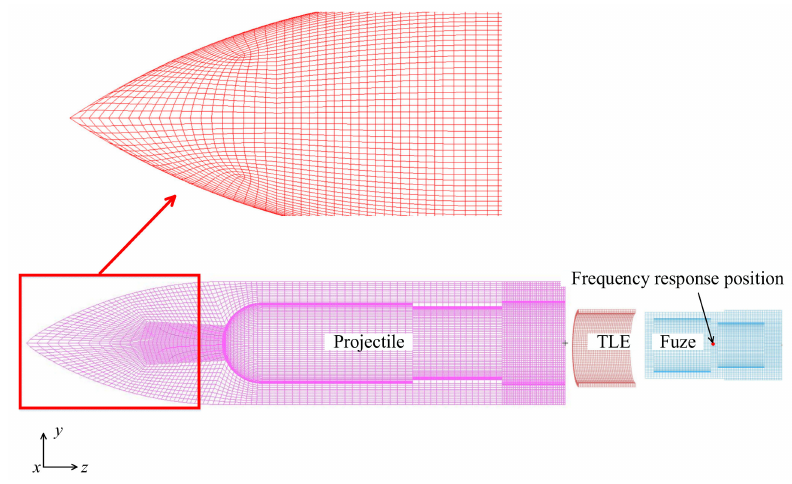
Figure 15. FE model of the projectile–fuse system (source elaborated by authors).